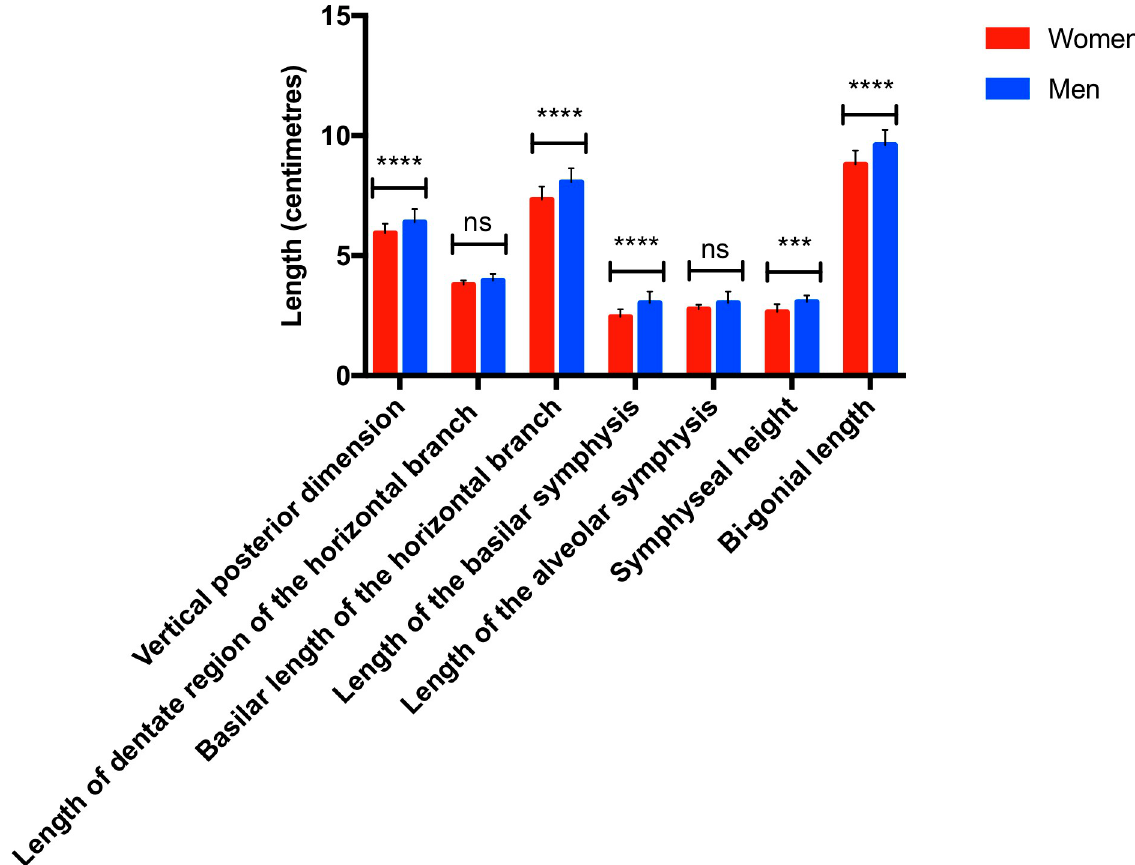
Fig 4. Histogram of the different length measurements obtained illustrating sexual dimorphism. Vertical posterior dimension: women: 5,9cm ± 0,4cm, men: 6,4cm ± 0,5cm, p < 0,0001. Length of dentate region of the horizontal branch: women: 3,8cm ± 0,2cm, men: 4,0cm ± 0,3cm, p = 0,21. Basilar length of the horizontal branch: women: 7,3cm ± 0,5cm, men: 8,0cm ± 0,6cm, p < 0,0001. Length of the basilar symphysis: women: 2,5cm ± 0,3cm, men: 3,0cm ± 0,5cm, p < 0,0001. Length of the alveolar symphysis: women: 2,8cm ± 0,2cm, men: 2,9cm ± 0,2cm, p = 0,90. Symphyseal height: women: 2,7cm ± 0,3cm, men: 3,1cm ± 0,3cm, p = 0,001. Bi-gonial length: women: 8,8cm ± 0,6cm, men: 9,6cm ± 0,6cm, p < 0,0001. n = 30 in each of the groups studied. ns: not statistically significant. ��� : p < 0,001. ���� : p < 0,0001.